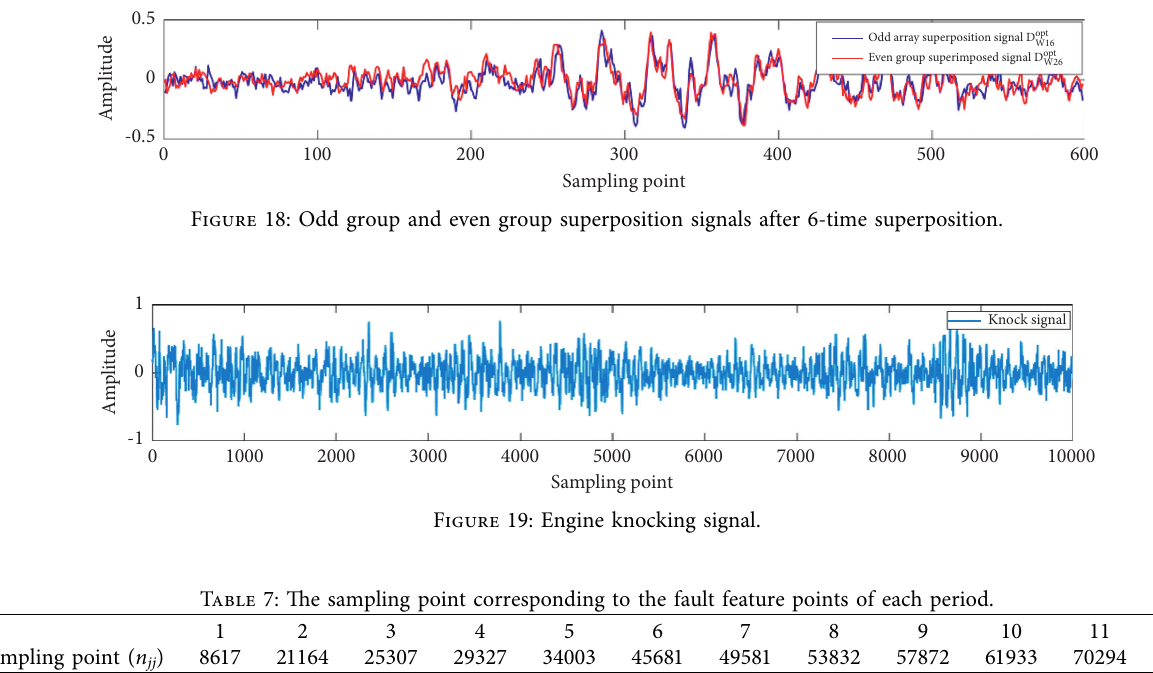
Table 8: The optimal offset τ opt